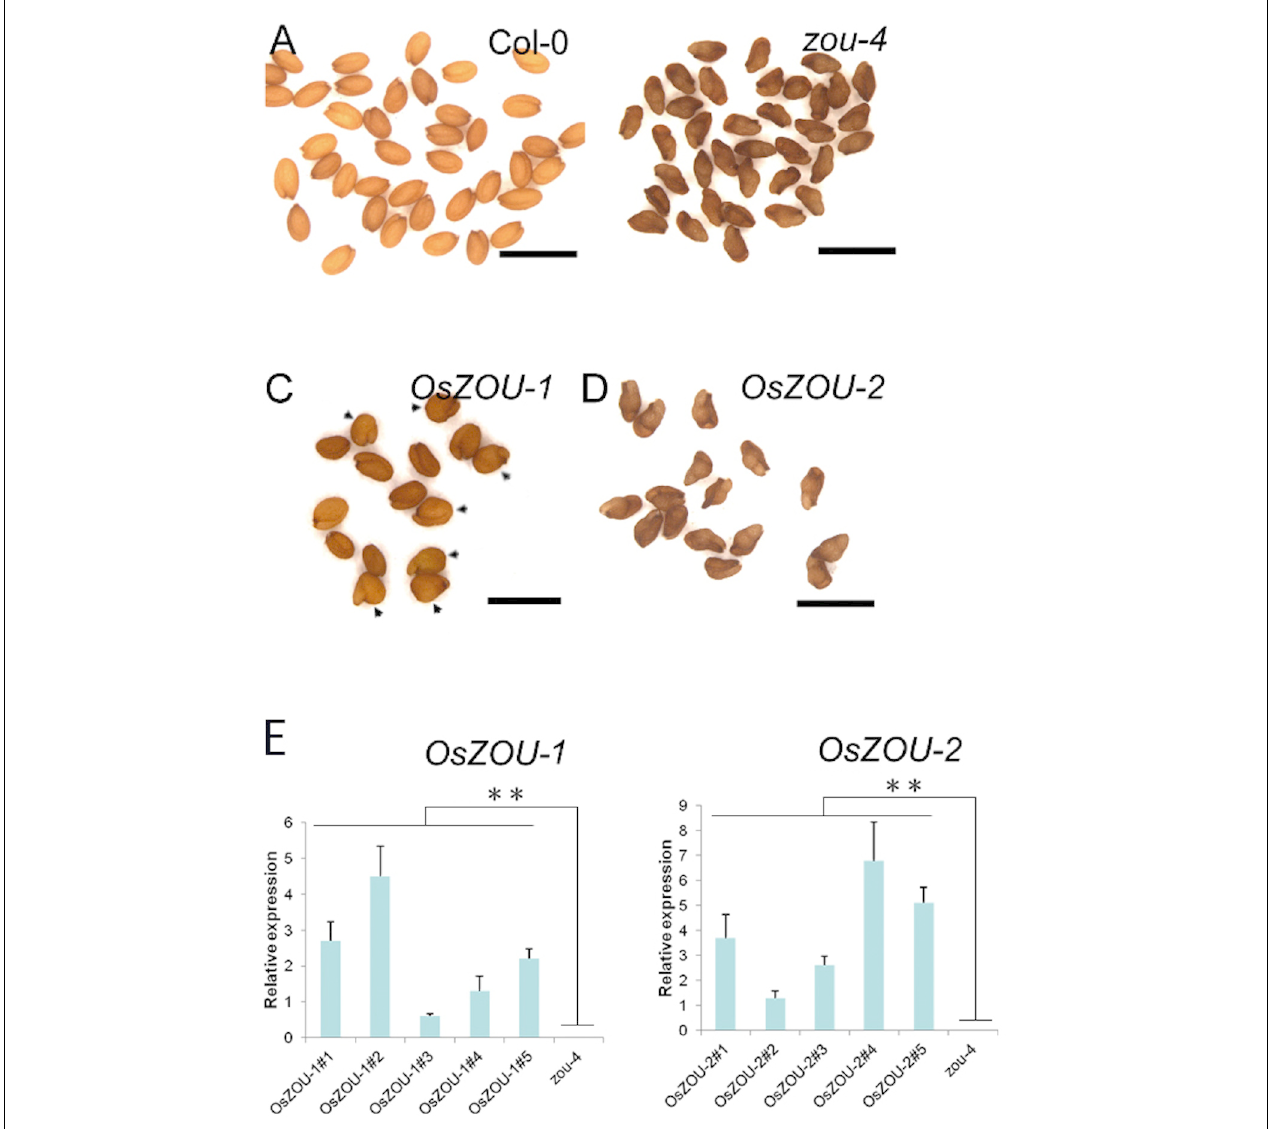
FIGURE 3 | Heterologous expression of OsZOUs in the Atzou-4 mutant. (A–D) Seed phenotypes of Col-0, Atzou-4 , OsZOU-1 , and OsZOU-2 transgenic lines (the seed phenotypes of independent transgenic events OsZOU-1#1 , #4 , #5 and OsZOU-2#1 , #3 , #5 were observed, but only images from OsZOU-1#4 and OsZOU-2#3 , considered representative for all other events, are presented here). The seeds from Col-0 are full (A) while those from zou-4 are abnormally shriveled (B) . In OsZOU-1 transgenic lines, the seeds are plump and some show irregular shapes, indicated by black arrow heads (C) , while the seeds of OsZOU-2 transgenic lines were shriveled, similar to the Atzou-4 mutant (D) . Scale bars = 1 mm. (E) qPCR analyses were performed to analyze the expression levels of OsZOUs in transgenic seeds at the heart stage. Five independent transgenic lines from each were examined and the un-transformed Atzou-4 mutants were selected as a negative control. The expression of OsZOUs was quantified relative to AtZOU expression in Col-0 seeds. Error bars represent the standard deviation calculated from three biological replicates, each containing three consecutive siliques at the mid to late heart stage, with AtEIF4 used as the reference gene. Student’s t -test value: ∗∗ p <